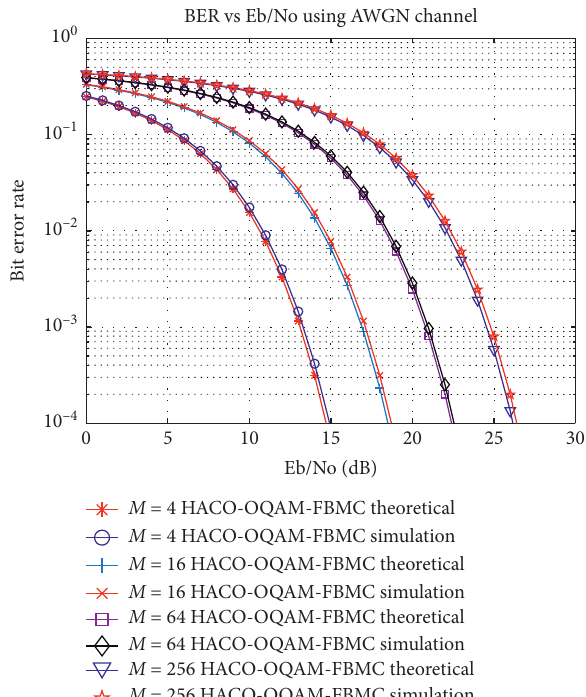
Figure 5: BER of HACO-OQAM-FBMC using 4-OQAM, 16-OQAM, 64-OQAM, and 256-OQAM